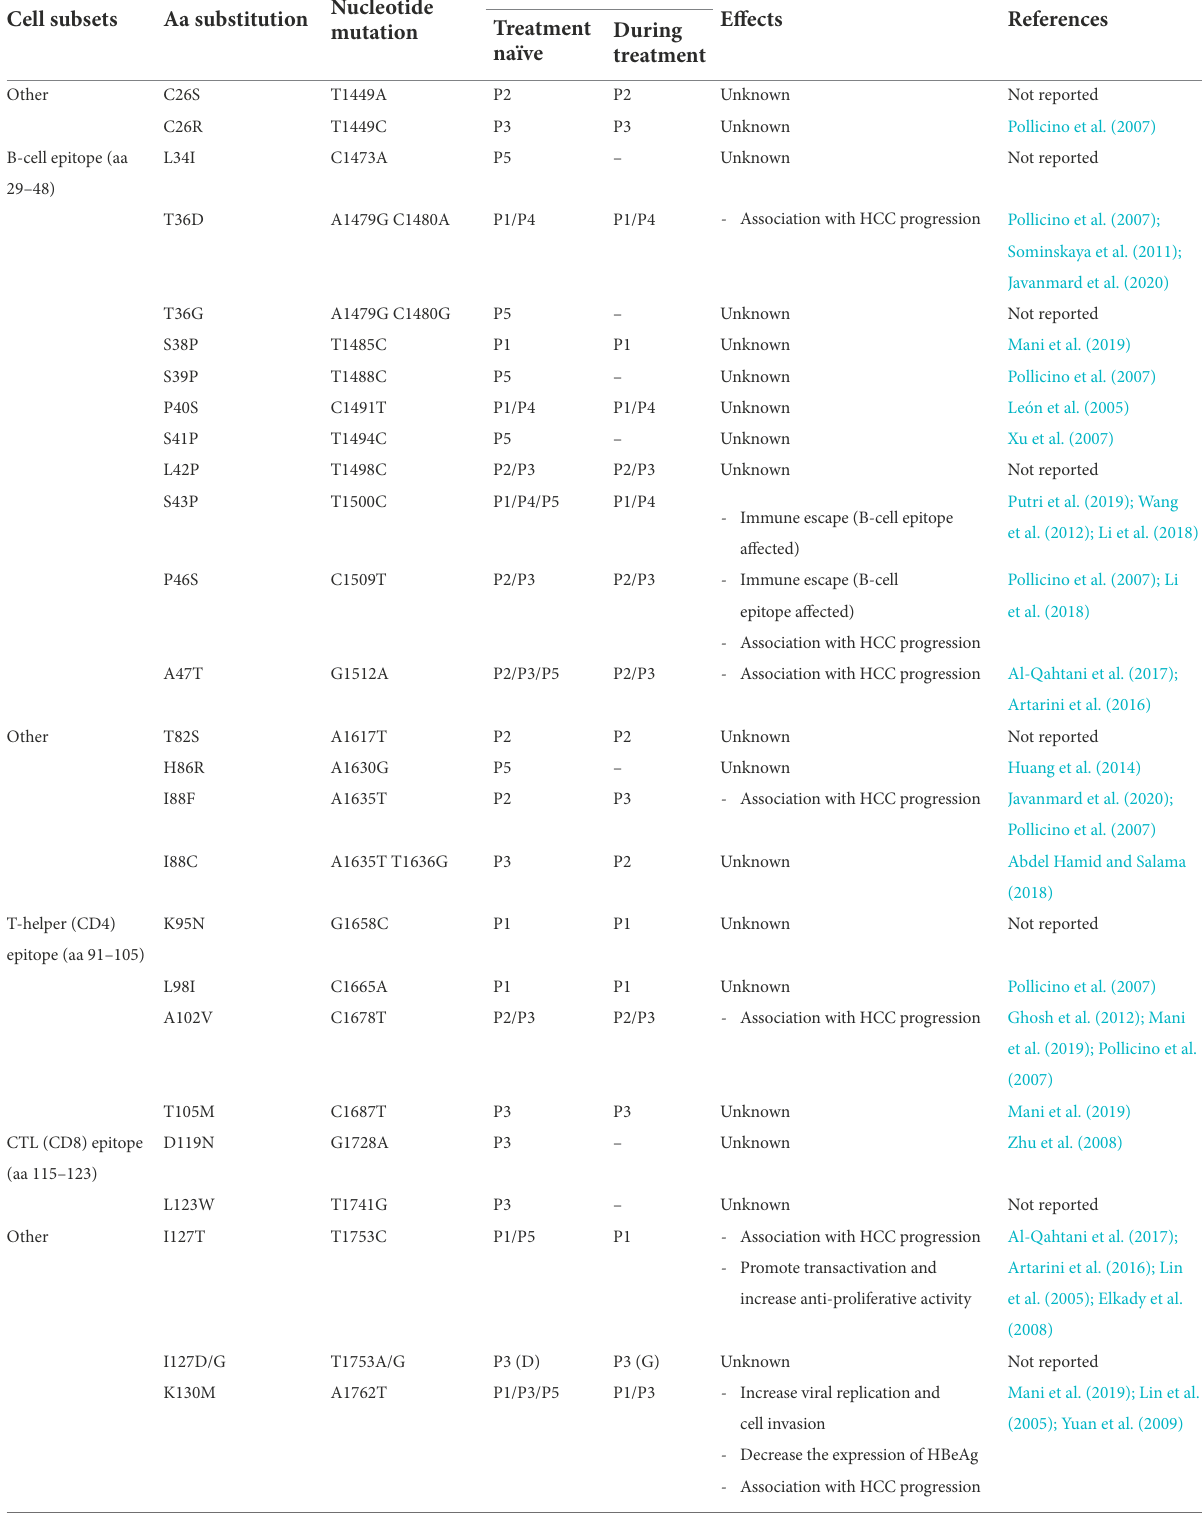
TABLE 5 Amino acid/nucleotide substitutions detected within the X gene sequences of the patients with their reported